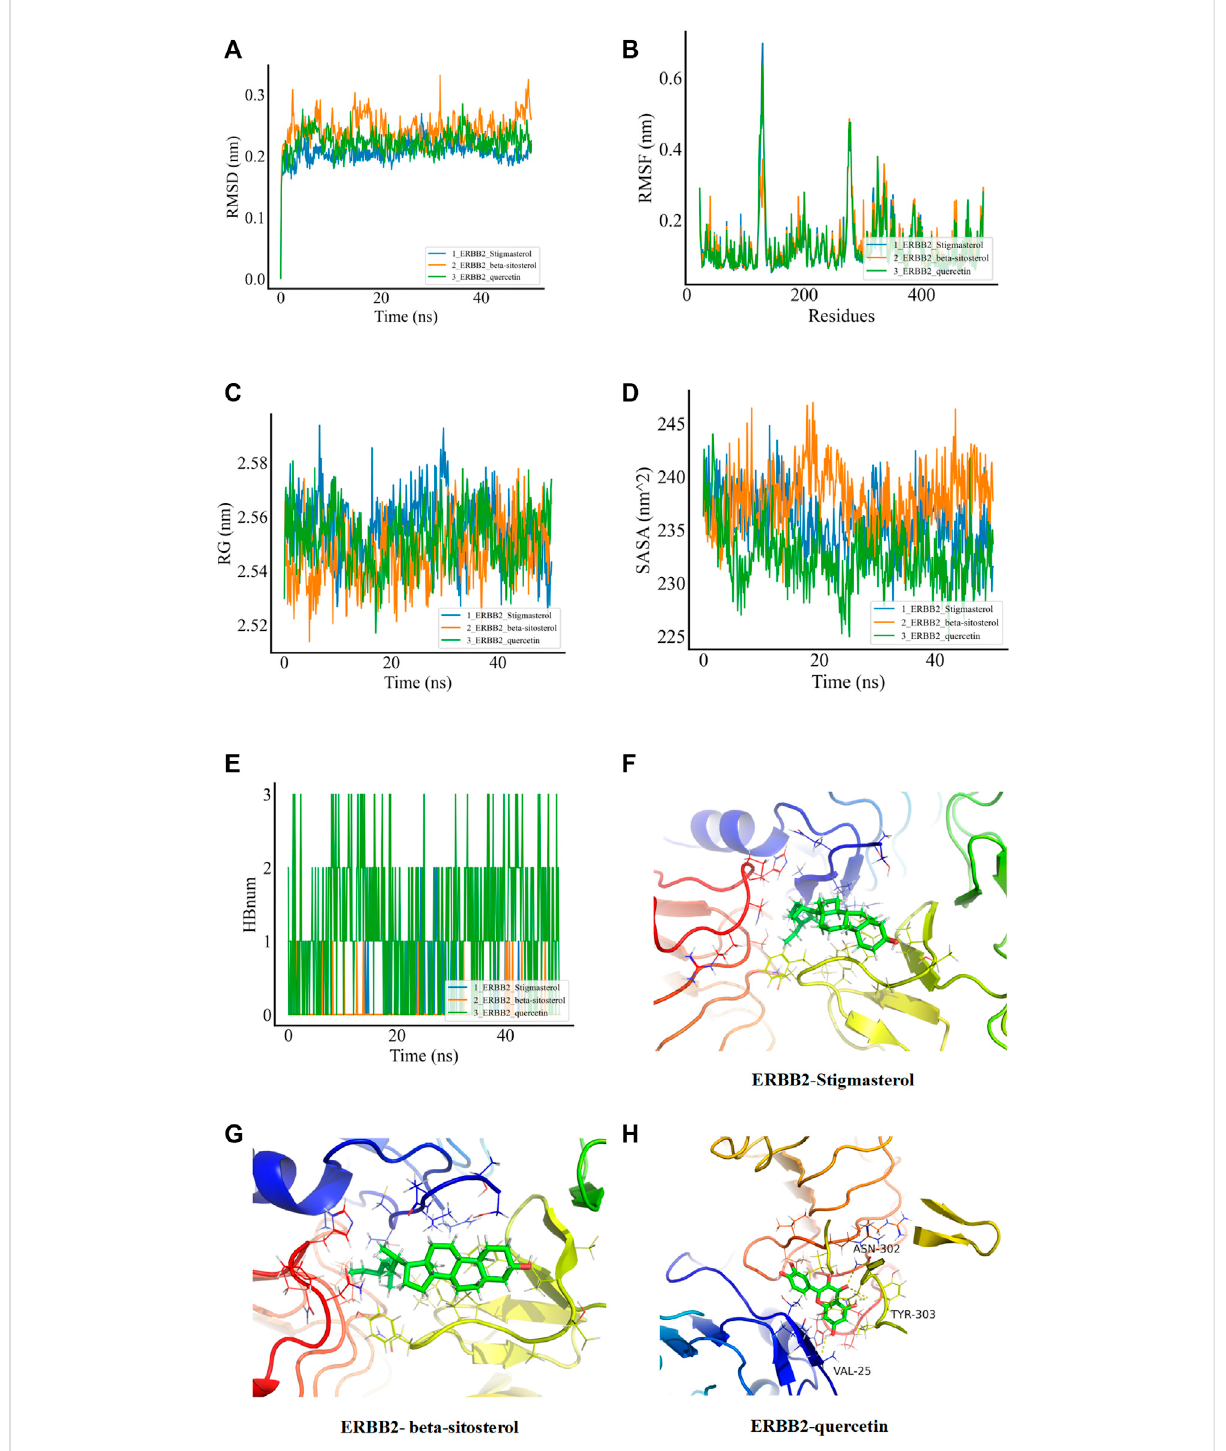
FIGURE 5 MDs of the ligand receptor complex. (A) Root mean square deviation (RMSD) of complex MDs. (B) RMSF changes in complex MDs. (C) Rg changes of complex MDs. (D) Solvent accessible surface area (SASA) of complex MDs. (E) Number of hydrogen bonds of complex MDs (HBNUM). (F – H) Molecular dynamics simulation of stable attitude and energy